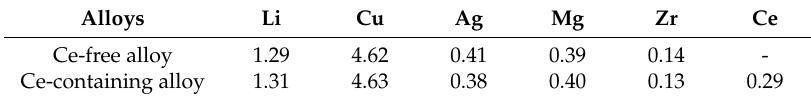
Table 1. Chemical composition of investigated alloys (wt